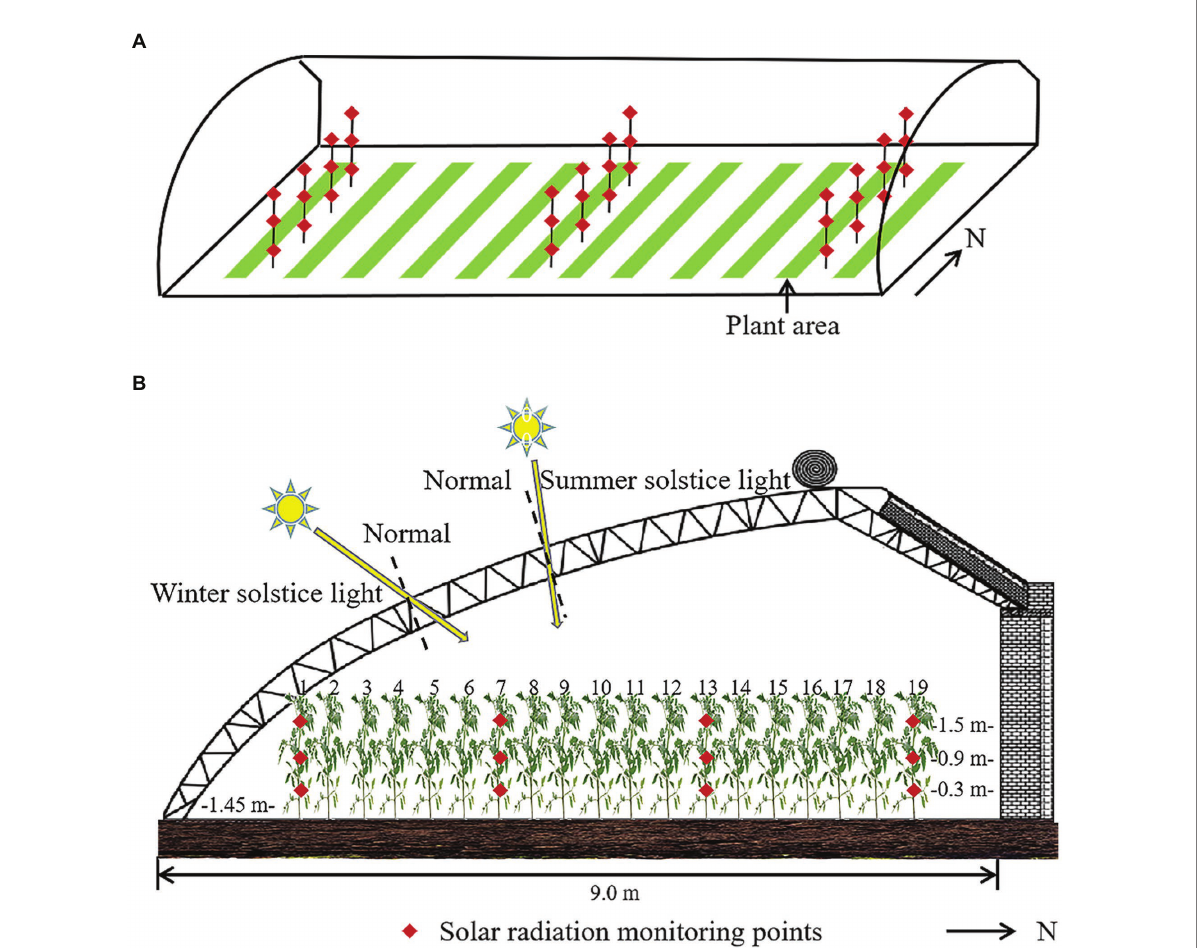
FIGURE 4 Layout of the measuring points of (A) the whole greenhouse, and (B) specific every measuring row. Same monitoring points were used for the scenes with and without reflective films. Solar radiation measuring points are at 0.3/0.9/1.5 m high close to the 1st, 7th, 13th, 19th tomato plant from south to